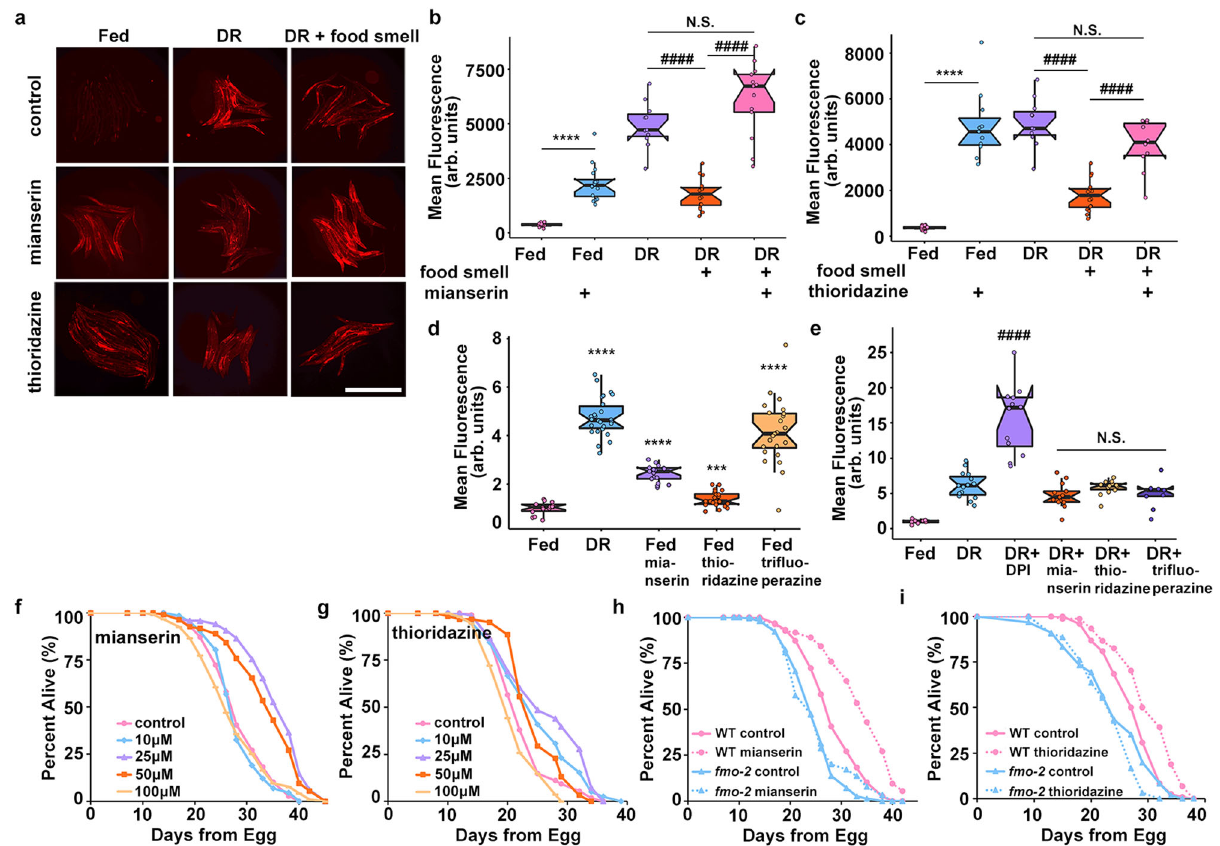
Fig. 2 Serotonin and dopamine antagonists induce fmo-2 and extend lifespan. Images ( a ) and quanti fi cation of fmo-2p :: mCherry given 100 µ M of mianserin ( b ) or thioridazine ( c ) (blue) in combination with DR and food smell (pink) compared to DR alone (purple). Scale bar, 1 mm. n = 16 (fed), 14 (fed + mianserin), 11 (DR), 16 (DR + food smell), 13 (DR + food smell + mianserin), 11 (fed + thioridazine), 10 (DR + food smell + thioridazine) biologically independent animals. p -value = 3.45e-09 (fed vs. fed + mianserin), 9.77e-10 (DR vs. DR + food smell), 3.34e-10 (DR + food smell